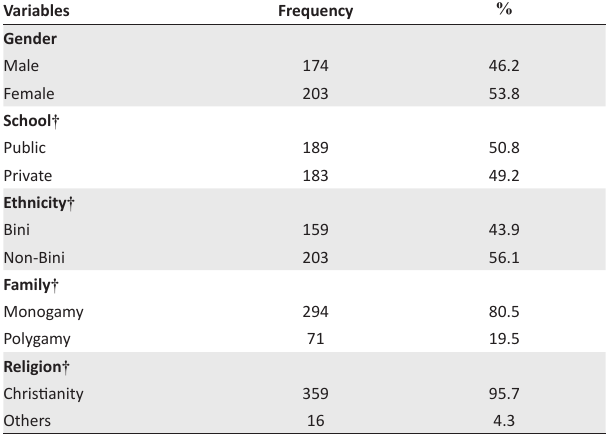
TABLE 1: Participants’ characteristics.